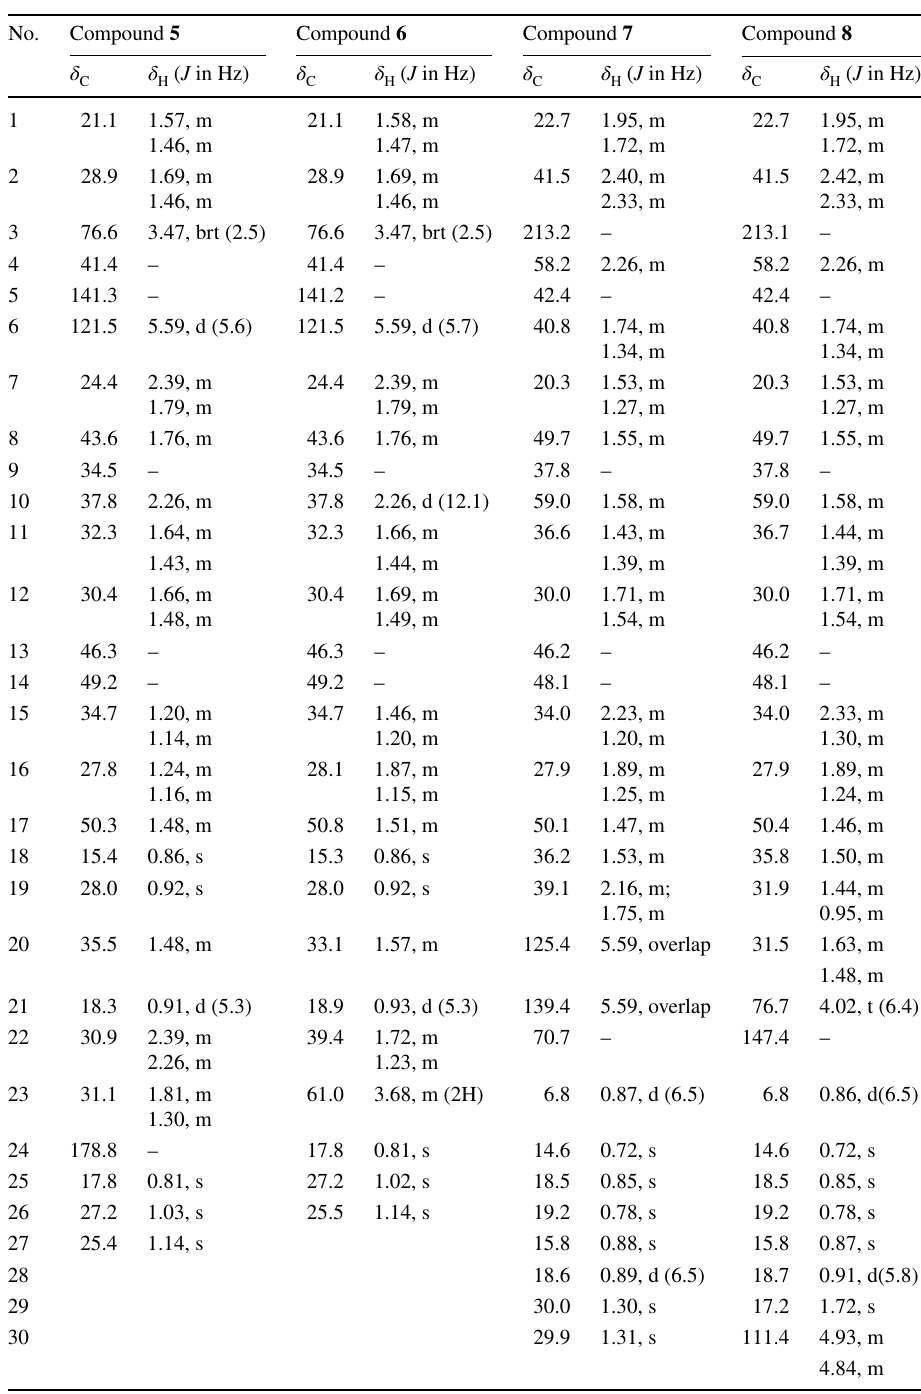
Table 2 1 H (500 MHz) and 13 C (125 MHz) NMR spectroscopic data of compounds 5 - 8 in CDCl 3